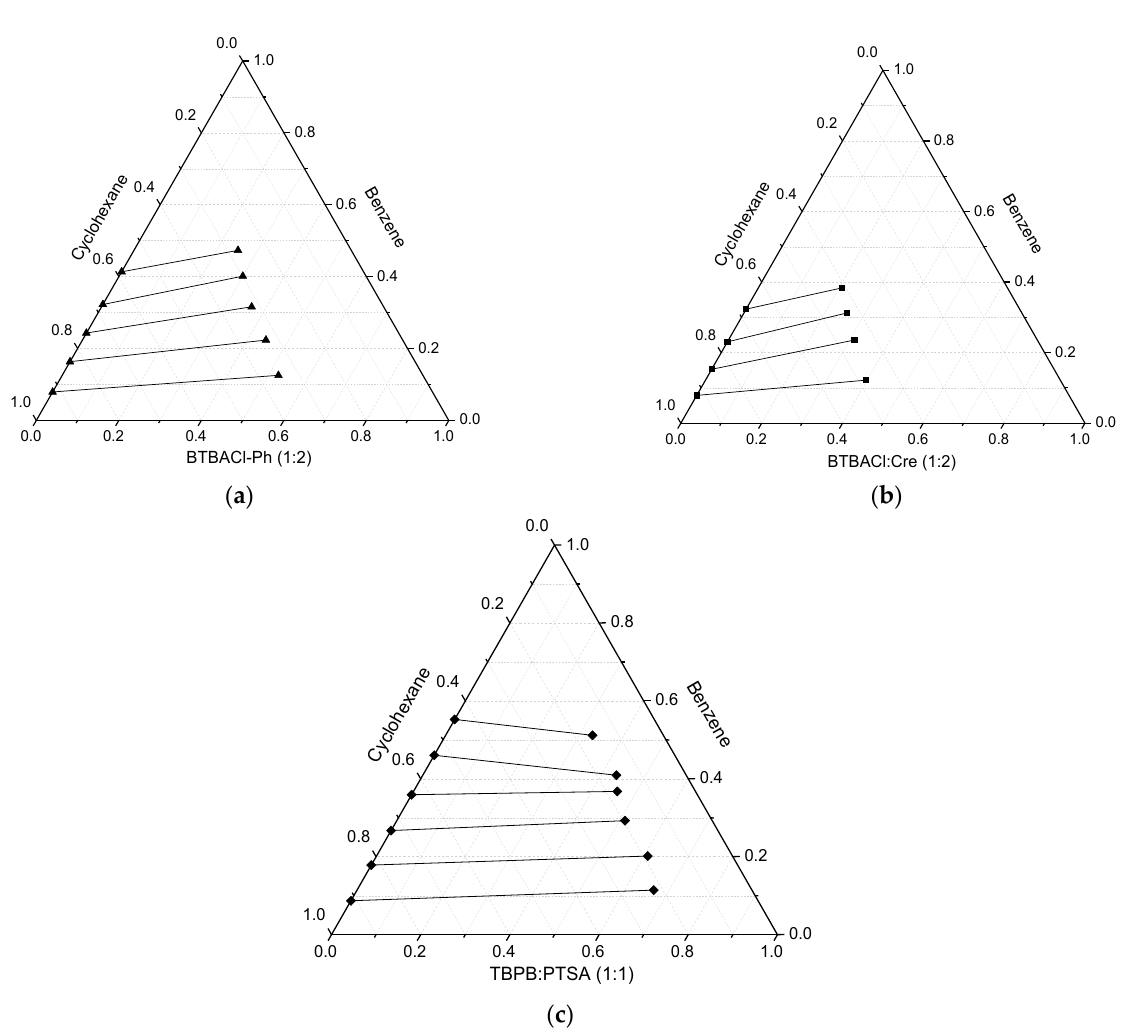
Figure 6. Variation of the distribution ratio and selectivity with benzene weight fraction in the feed for [Benzene (1) + Cyclohexane (2) + BTBACl:Cre (1:2) (3)]. Figure 7. Variation of the distribution ratio and selectivity with benzene weight fraction in the feed for [Benzene (1) + Cyclohexane (2) + TBPB:PTSA (1:1) (3)].